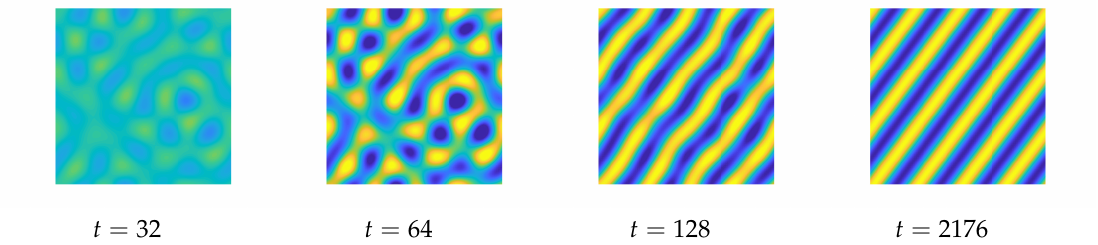
Figure 4. Evolution of φ ( x , y , t ) using the method S3 with ( ¯ φ , (cid:101) ) = ( 0.02,0.1 ) . In each snapshot, the yellow, green, and blue regions indicate φ = 0.3810, 0.0195, and